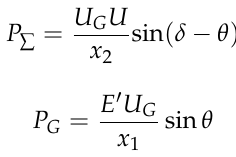
Figure 2. Schematic diagram of the two-machine infinite-bus system.